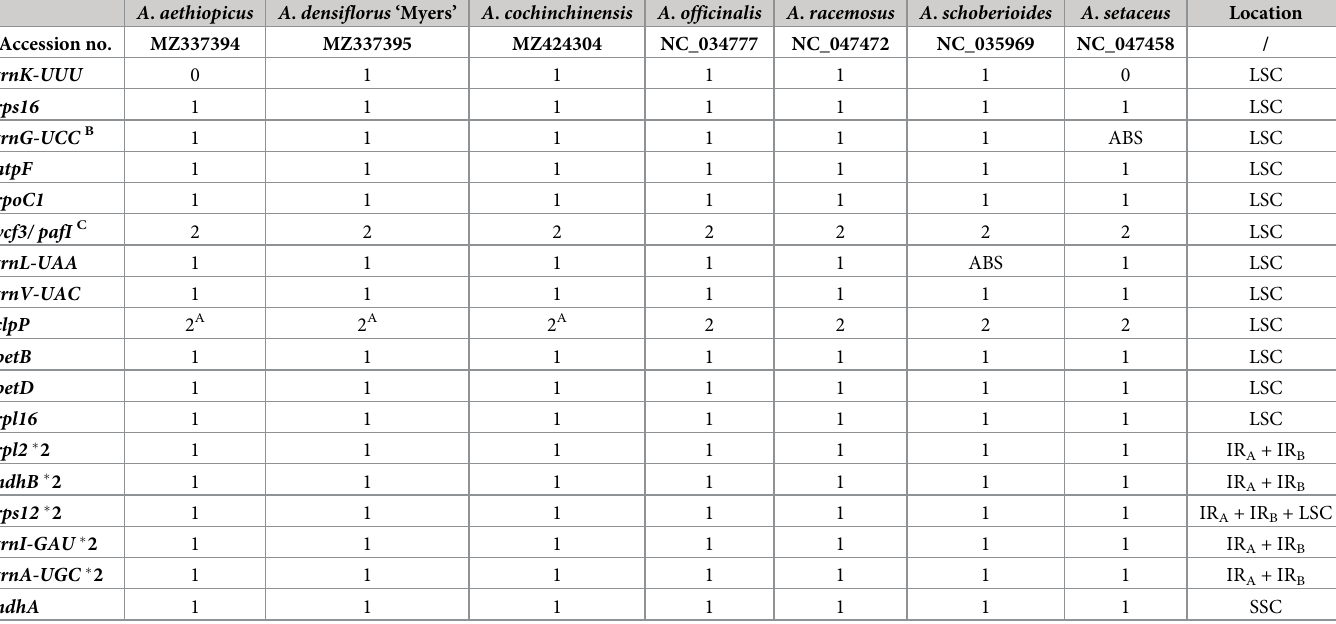
Table 4. Intron-containing genes in the chloroplast genomes of seven Asparagus species. A . aethiopicus A . densiflorus ‘Myers’ A . cochinchinensis A . officinalis A . racemosus A . schoberioides A . setaceus Accession no.